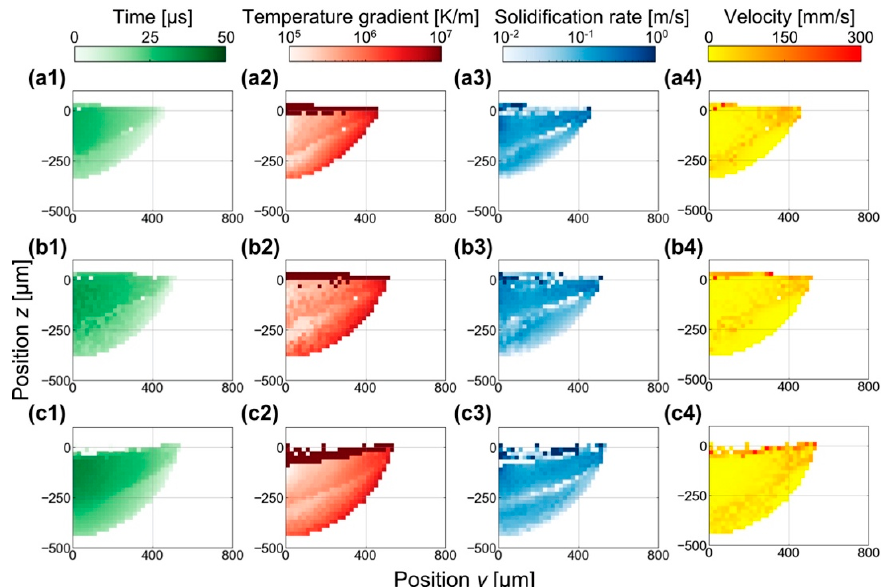
Figure 9. CtFD simulated cross-sectional melt pools of 304 SS colored by ( a1 – c1 ) a solidifica- tion time, ( a2 – c2 ) a temperature gradient, G , ( a3 – c3 ) a solidification rate, R , and ( a4 – c4 ) a flow velocity, U . The beam powers were ( a1 – a4 ) P = 600 W, ( b1 – b4 ) P = 900 W, and ( c1 – c4 ) P = 1200 W. Figure 10a,b show the plot of the solidification conditions of each mesh in the G – R space. Except for the surface regions, all the regions exist under conditions of G in the range of 1.0 × 10 5 –3.0 × 10 7 K/m and of R in the range of 10 − 2 –10 0 m/s. The average solidifi- cation conditions and its magnified picture are shown in Figure 10c,d, respectively. Com- pared with 316L SS, 304 SS solidified with a smaller G . In both SSs, the R slightly decreases with an increase in the beam power.